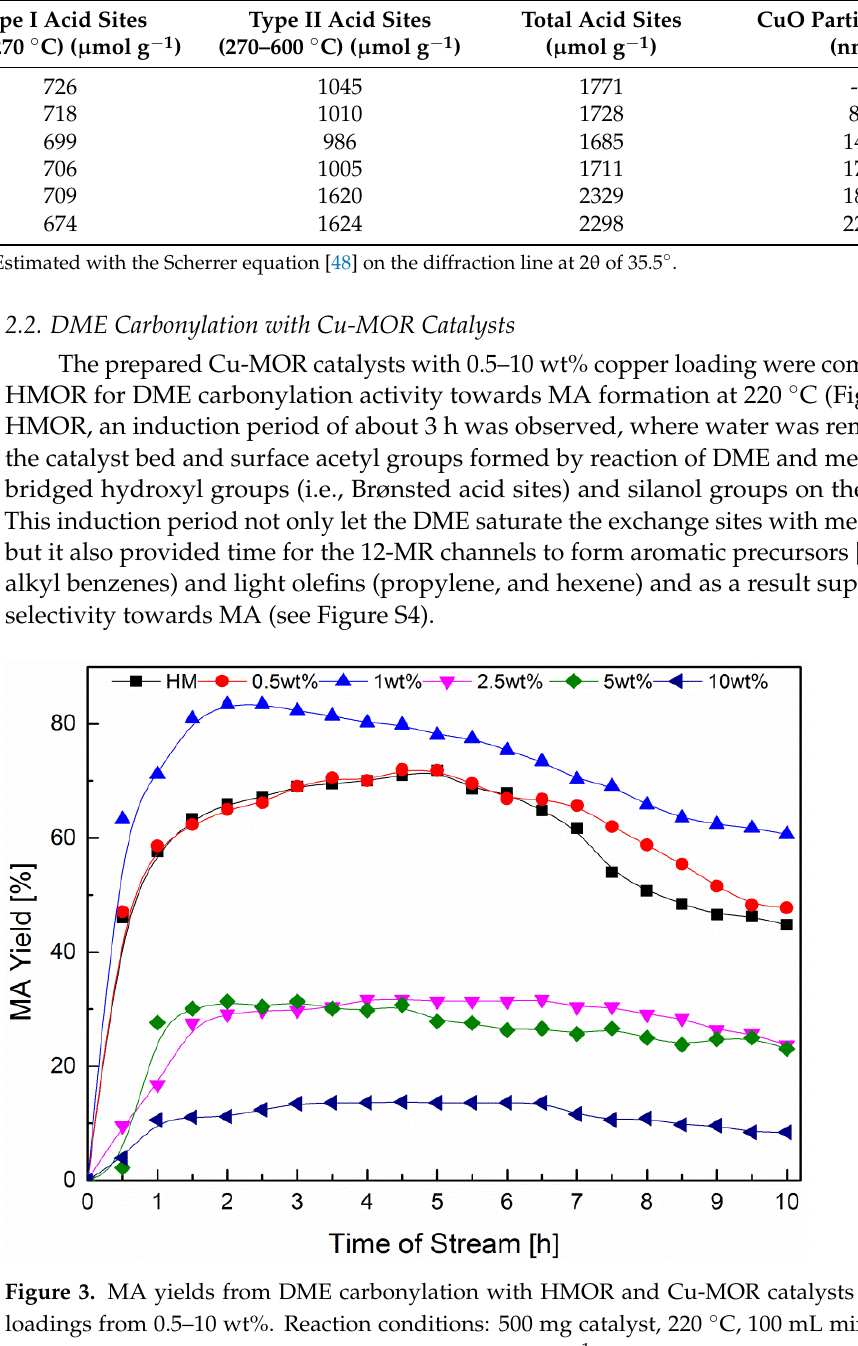
Table 2. Acid type distribution of MOR and Cu-MOR from NH 3 -TPD.